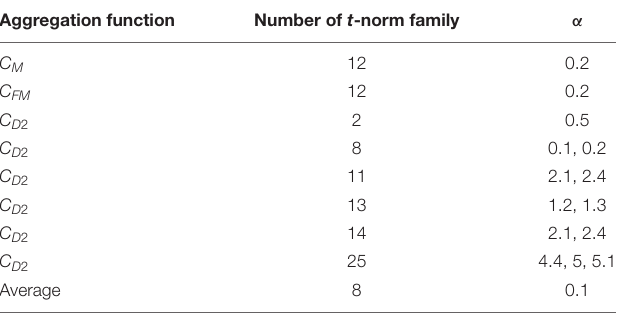
TABLE 3 | The best choices of t -norms for various generalizations of the Choquet integral.